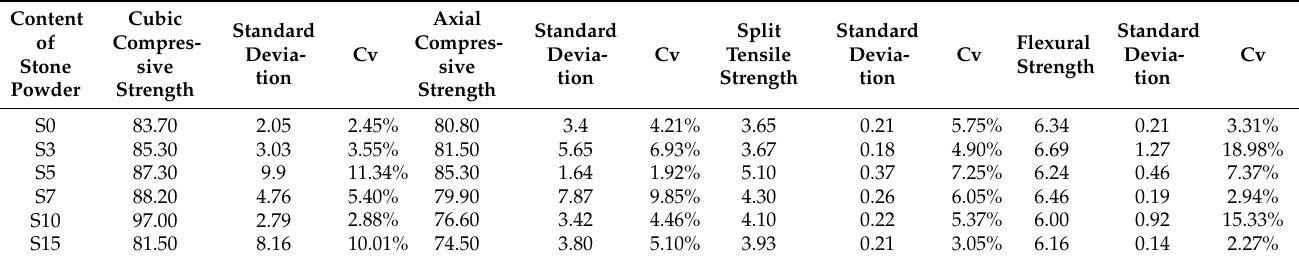
Table 8. Cubic compressive, axial compressive, split tensile, and flexural strength of concrete with different stone powder contents (MPa) over 28